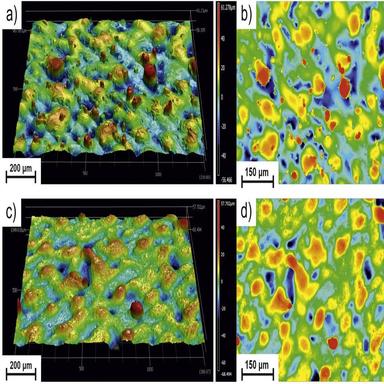
Confocal microscopy of the benchmark shown in. (a) 3D image of the as-built condition, (b) top view of the as-built condition, (c) 3D image after sandblasting, and (d) top view after sandblasting.